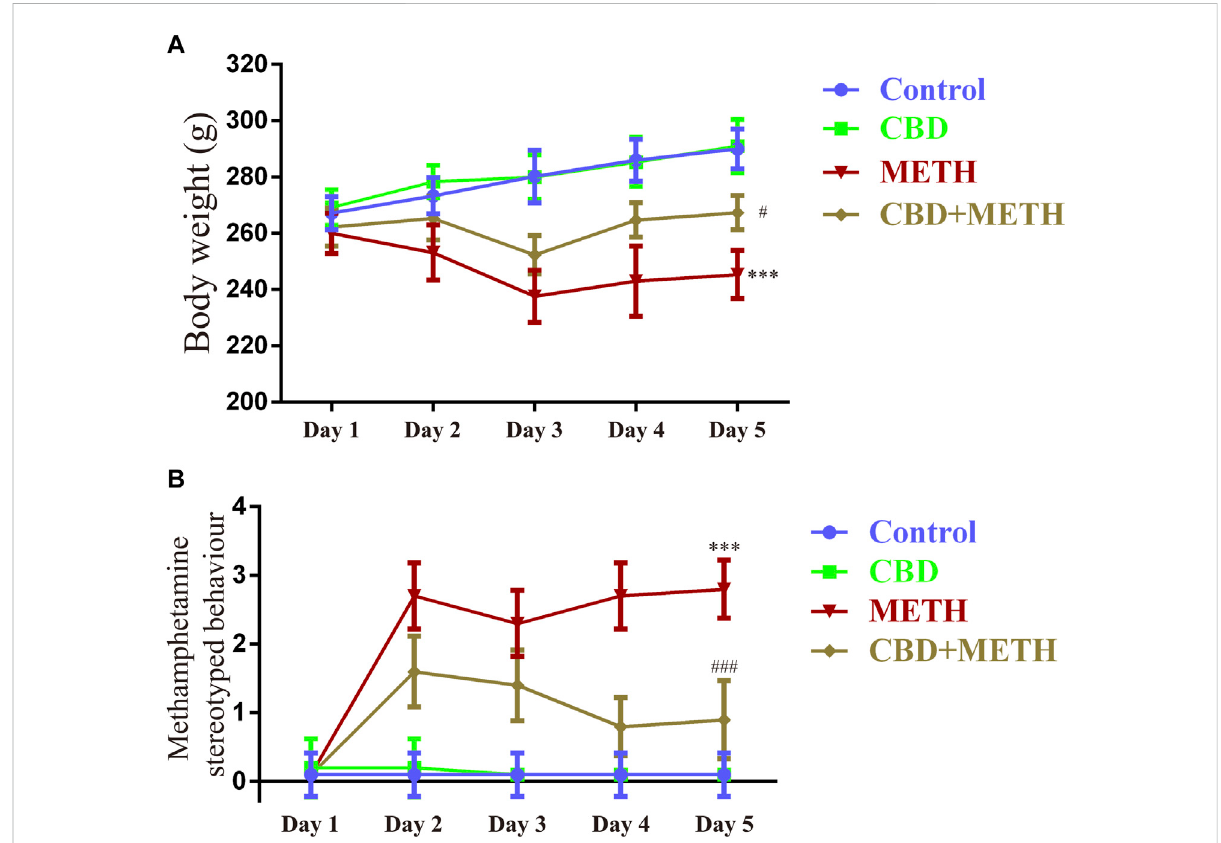
FIGURE 9 Changes in body weight and stereotyped behavior in rats repeatedly exposed to CBD and/or METH. (A) Changes in body weight in rats. (B) Changesinstereotypedbehaviorinrats.*** p < 0.001comparedwithcontrolgroup, # p < 0.05or ### p < 0.001comparedwithMETHgroup;Tukey HSD post-hoc comparison after signi fi cant